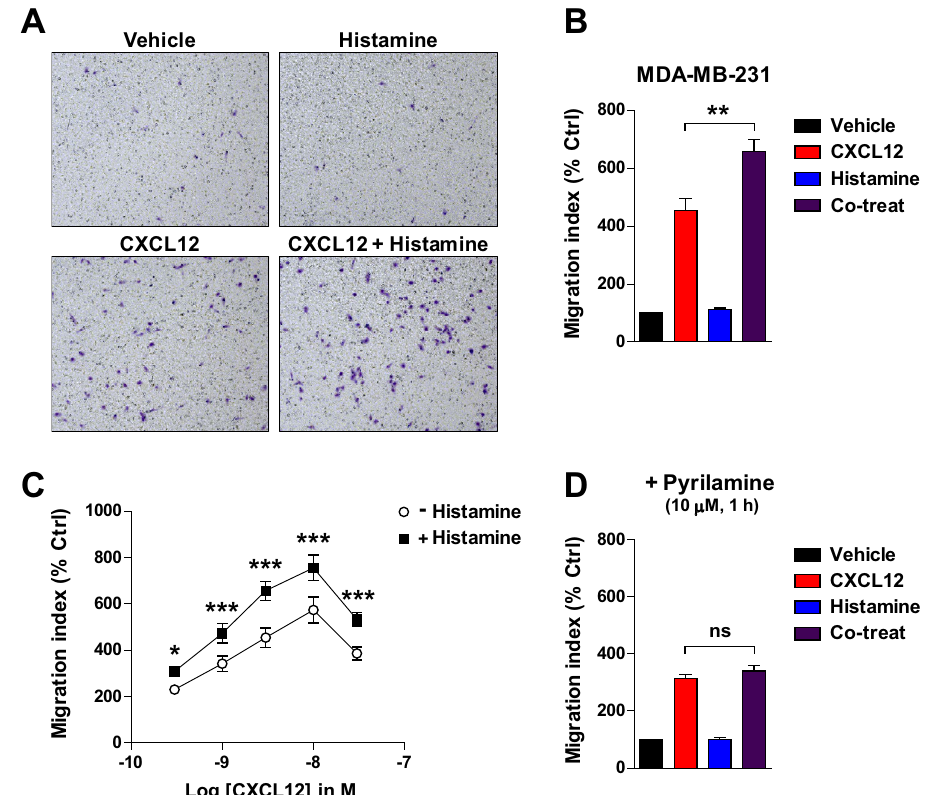
Figure 6. Costimulation of CXCR4 and HRH1 enhances CXCR4-mediated migration of MDA-MB-231 cells. ( A ) Representative images of MDA-MB-231 cells migrated by vehicle, 3 nM CXCL12, 100 nM histamine, or both agonists. ( B ) Quantification of migration shown in ( A ). Data are expressed as mean ± s.e.m. (n = 3). ** P < 0.01. ( C ) CXCL12-induced cell migration in the absence or presence of 100 nM histamine. * P < 0.05; *** P < 0.001. ( D ) Cells were treated with 10 μM pyrilamine for 1 h before the migration assay with 3 nM CXCL12, 100 nM histamine, or both. Data are expressed as mean ± s.e.m. (n = 3). Ns not significant.